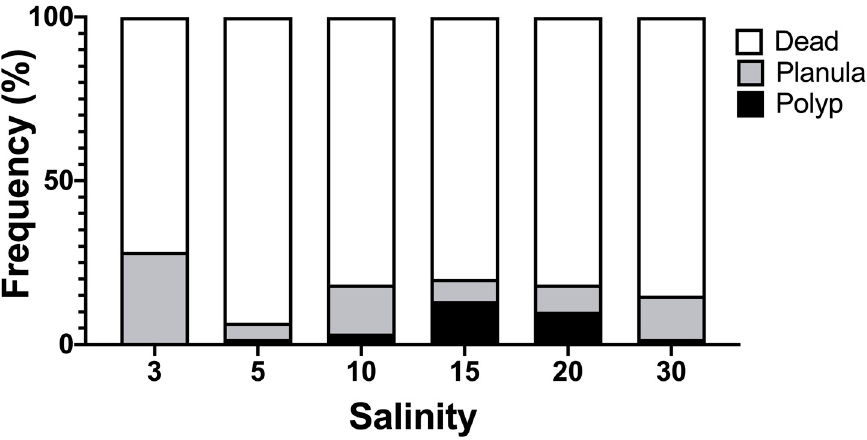
Figure 9. Frequency of settled, swimming and dead planulae at different 6 salinity levels over 7